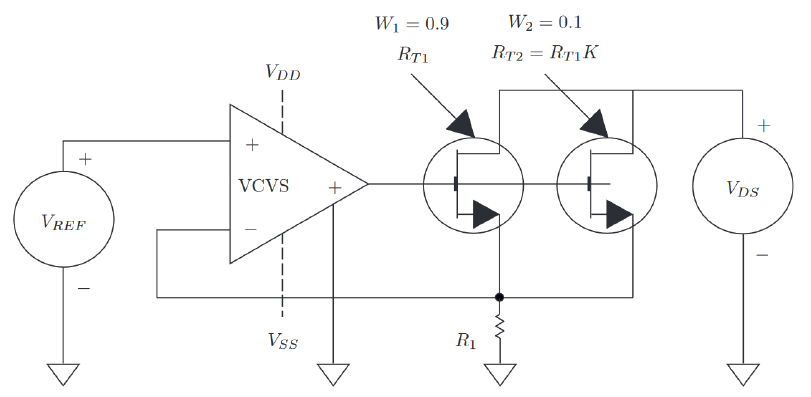
Figure 5. Scheme of MOSFET aging